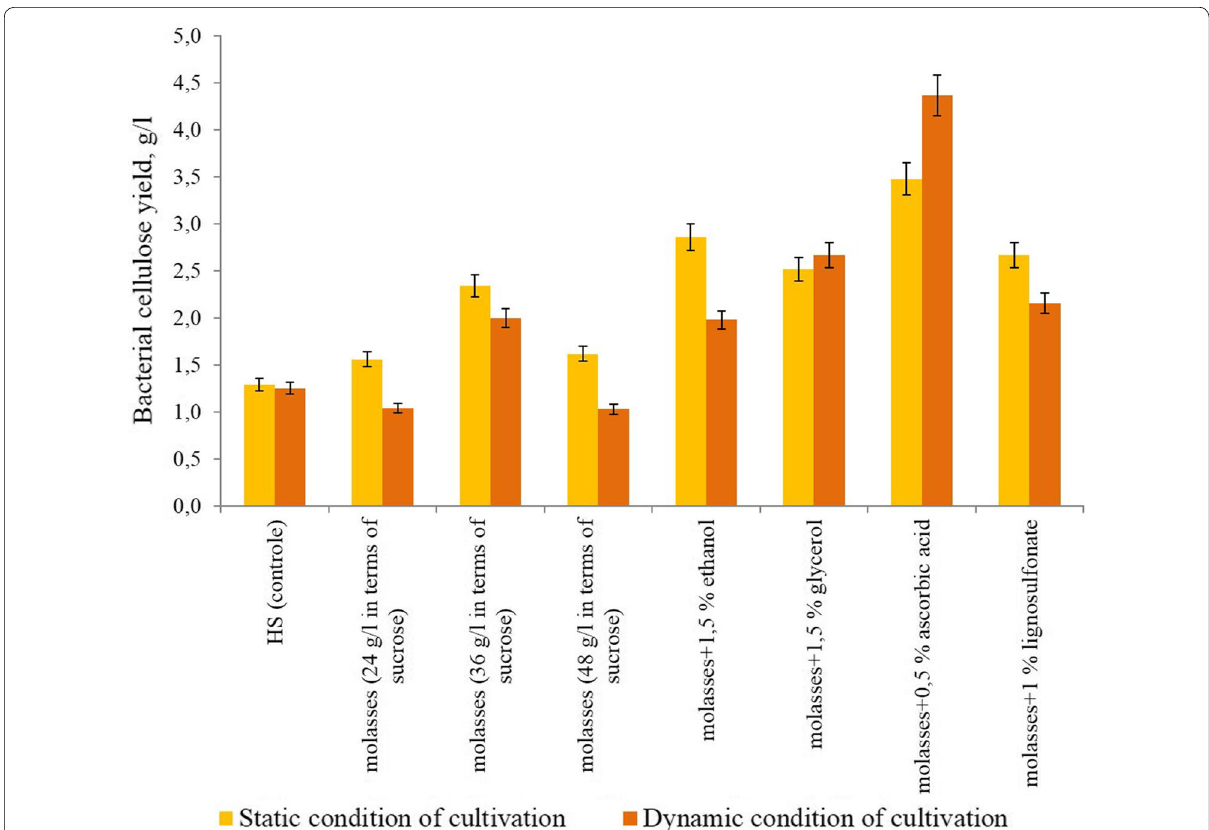
Fig. 1 Yield of bacterial cellulose under static and dynamic condition of cultivation on various